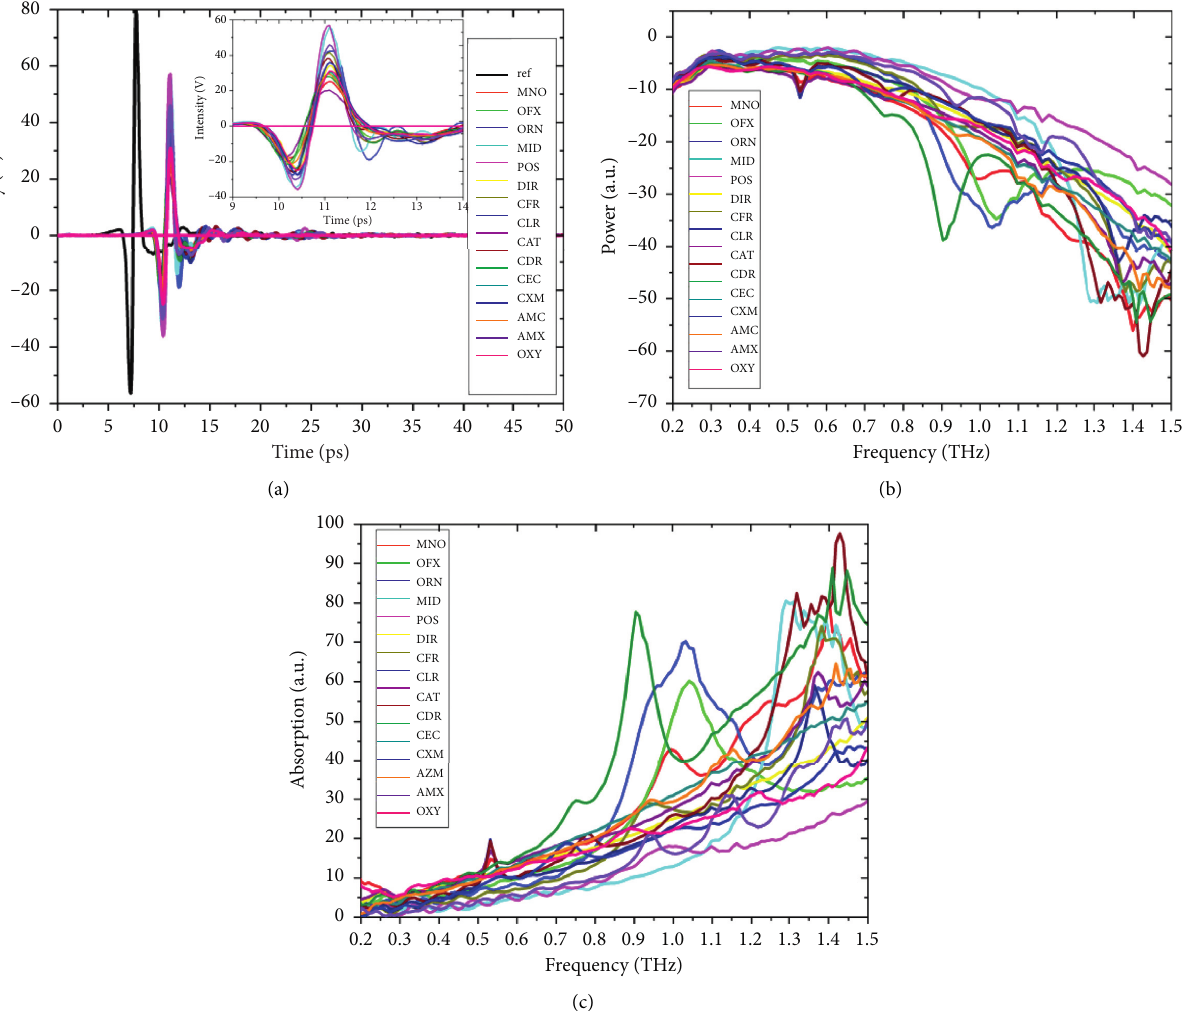
Figure 2: THz spectra of different types of antibiotics. (a) THz time-domain spectra. (b) THz frequency spectra. (c) THz absorbance